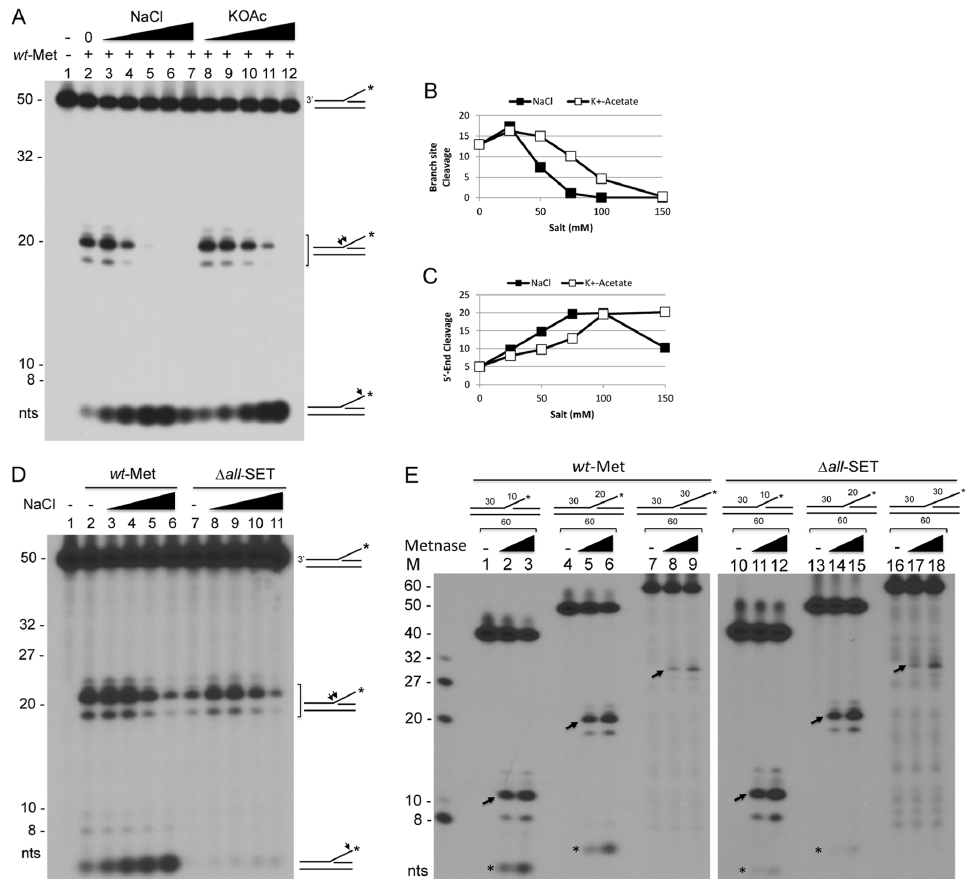
Fig 5. The Metnase SET domain is required for a preferential cleavage of the 5 ’ end of a 5 ’ -flap DNA in the presence of high salt. (A) Metnase prefers cleavage of the branch site at low salt, while it likes cleavage of the 5 ’ -end of a 5 ’ -flap DNA in the presence of high salt. Wt -Metnase (50 ng) was incubated with 60 fmol of the 5 ’ - 32 P-labeled ( * ) DNA for 120 min in the presence of increasing concentrations (0, 25, 50, 75, 100, and 150 mM) of NaCl or potassium acetate (KOAc) prior to 12% denatured PAGE (+ 8M urea) analysis. Arrows on the right mark the cleavage sites on the 32 P-labeled ( * ) 5 ’ -flap DNA. (B-C) Metnase-mediated cleavage of the branch site (panel B) and the 5 ’ end of ss-overhang (panel C) of a 5 ’ -flap DNA shown in Panel A was quantified. (D) Cleavage of the 5 ’ end of a 5 ’ - 32 P-flap DNA with wt-Metnase and the SET deletion mutant in the presence of varying salt concentrations. Fifty ng of wt- Metnase or the Δ all -SET was incubated with a 5 ’ - 32 P-flap DNA in the presence of increasing concentrations (0, 25, 50, 75, and 100 mM) of NaCl. Arrows on the right mark the cleavage sites on the 5 ’ - 32 P-labeled ( * ) flap DNA. (E) Metnase exhibits branch site cleavage of the 5 ’ -flap DNA with different sizes of ss- overhang. Wt-Metnase (50 or 100 ng; lanes 1 – 9) or the SET deletion mutant (lanes 10 – 18) was incubated with the 5 ’ - 32 P-labeled 5 ’ -flap DNA in different length of ss-overhang (10-mer, lanes 1 – 3 & 10 – 12; 20-mer, lanes 4 – 6 & 13 – 15; 30-mer, lanes 7 – 9 & 16 – 18). Arrows mark the major branch site cleavage with the 32 P-labeled 5 ’ -flap DNA. M on the left represents DNA